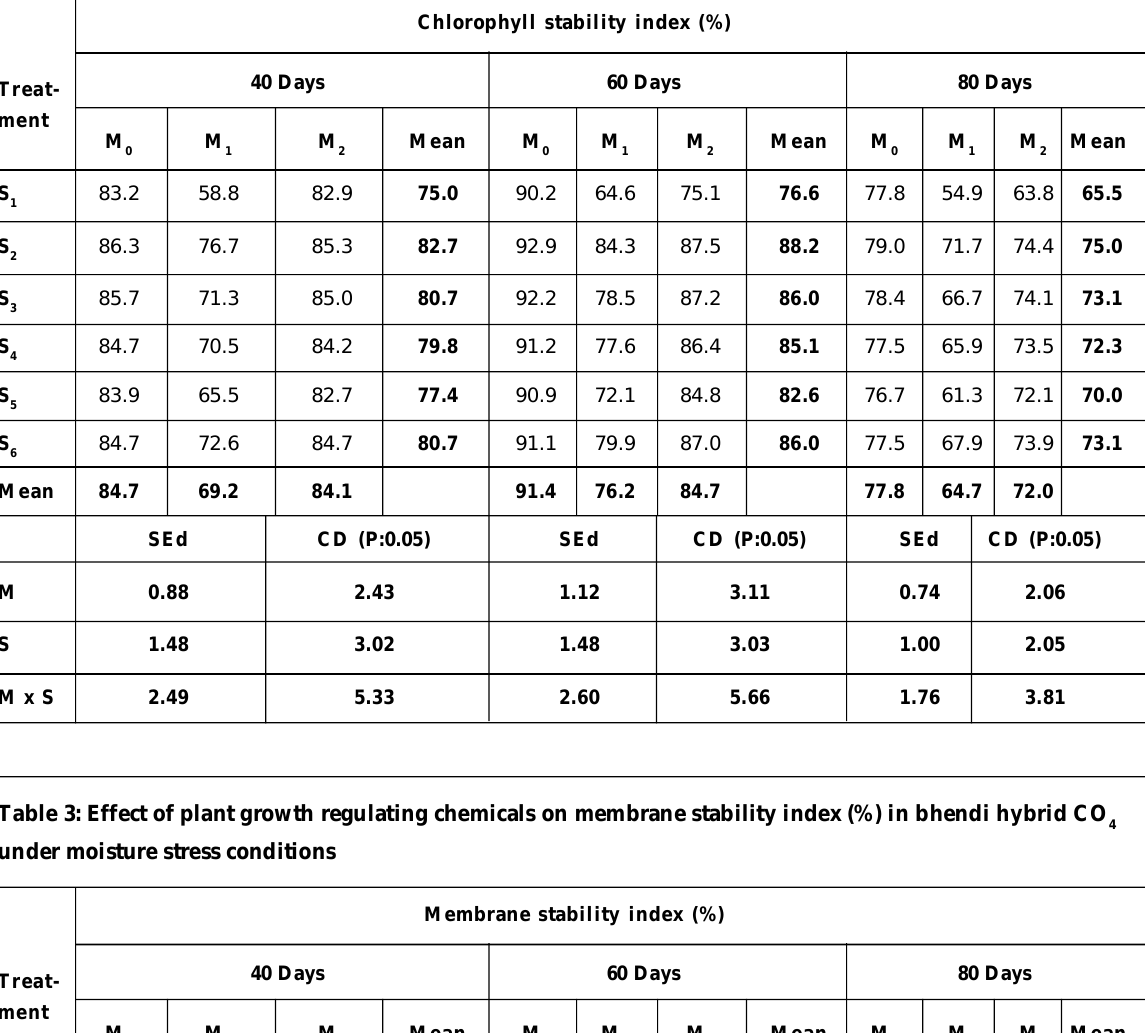
Table 2: Effect of plant growth regulating chemicals on chlorophyll stability index (%) in bhendi hybrid CO under moisture stress conditions